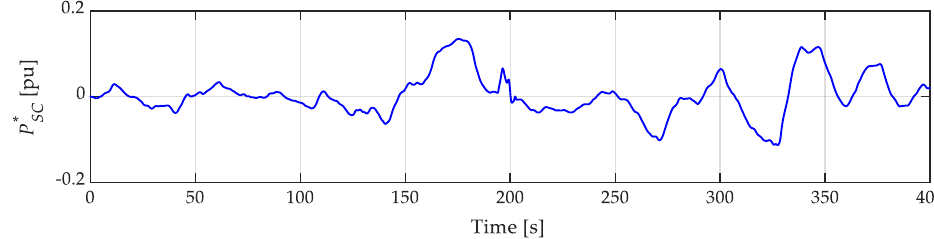
Figure 12. Power set-point generated by the algorithm that serves as the command for the SC–ESS to smooth the wind power.